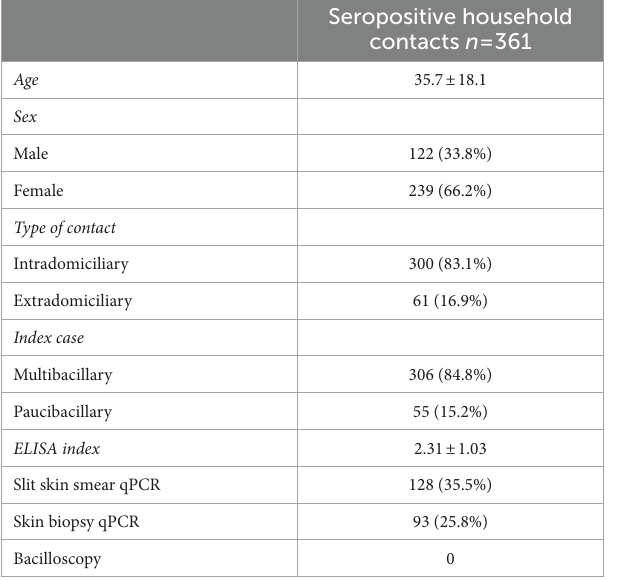
TABLE 3 Distribution of peripheral nerves most affected in the electroneuromyographic evaluation of the seropositive household contacts of leprosy patients.